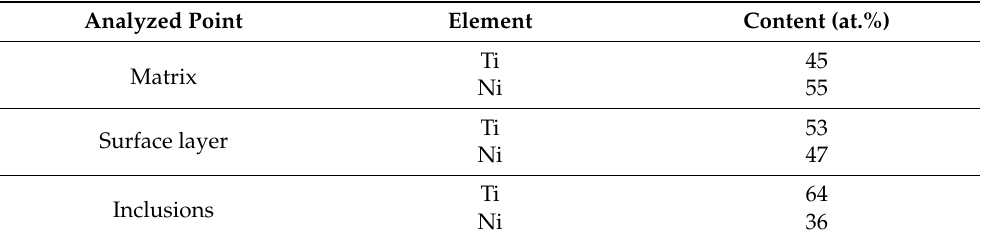
Table 3. Elemental content at different points of cross-sectional sample TN-30 according to EDX data. Analyzed Point Element Content